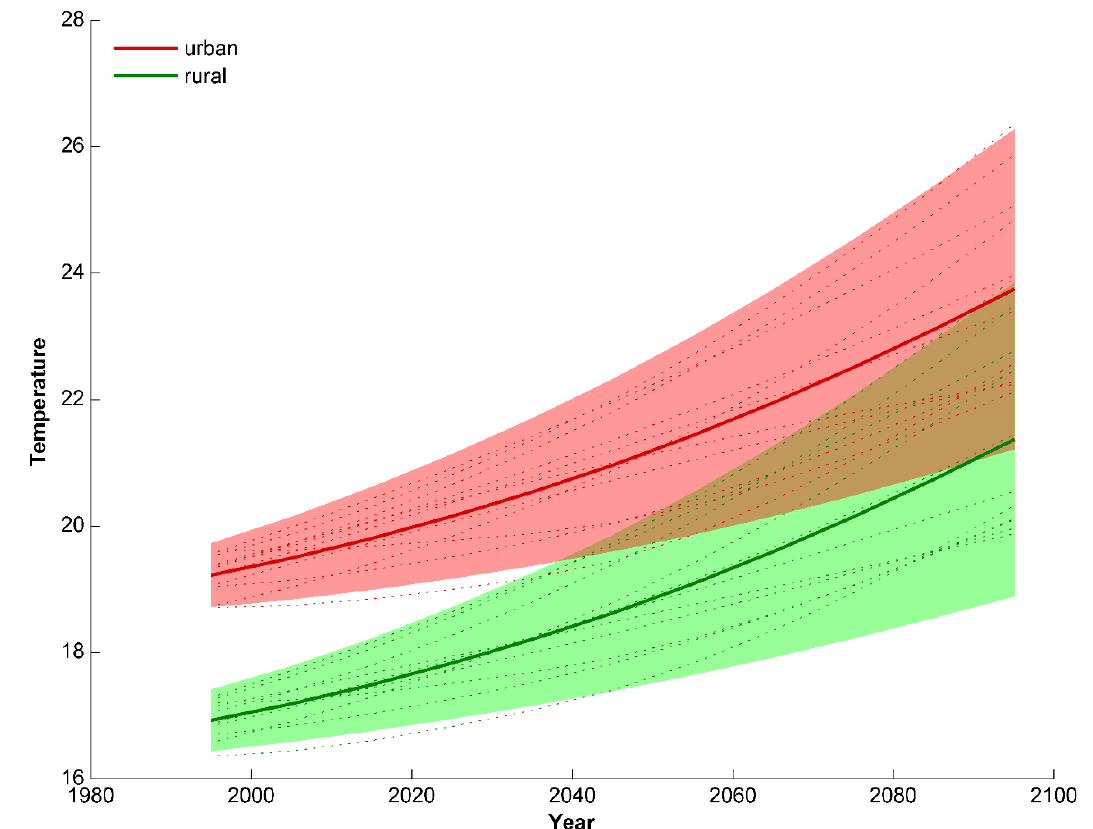
Figure 8. Evolution of the rural (green) and urban (red) 95th percentile of the minimum temperature in Antwerp. The thick lines show the ensemble mean, while the shaded areas indicate the 5%–95% range based on assuming a normal distribution for the ensemble. Dotted lines indicate the results obtained with the individual GCM forcings. Note that in order to construct this figure, also model results for the period 2026–2045 were used, and an interpolation was made to span the periods not covered by the